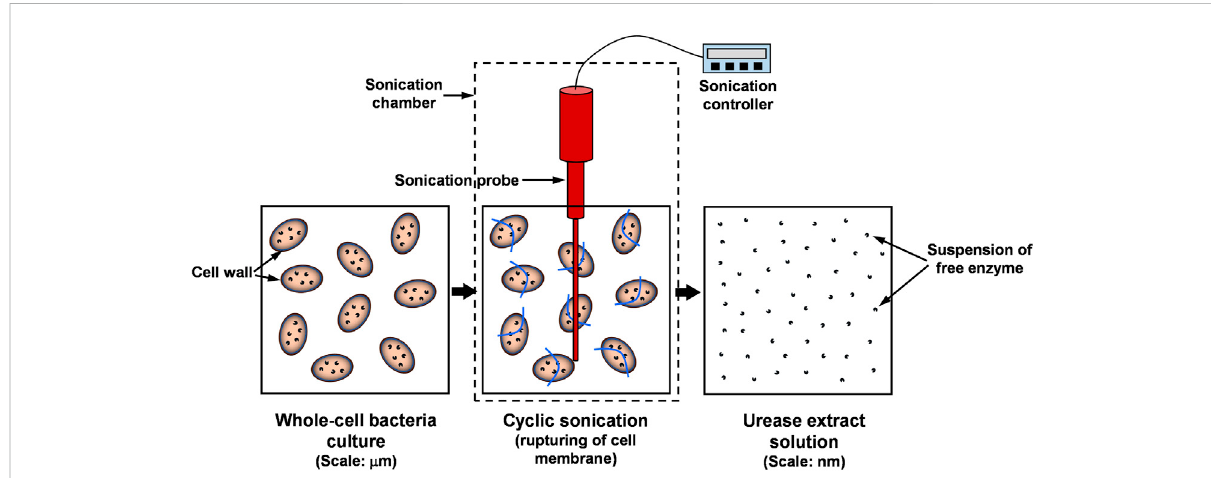
FIGURE 1 Conceptual illustration of the lysing of bacteria cells during sonication process.